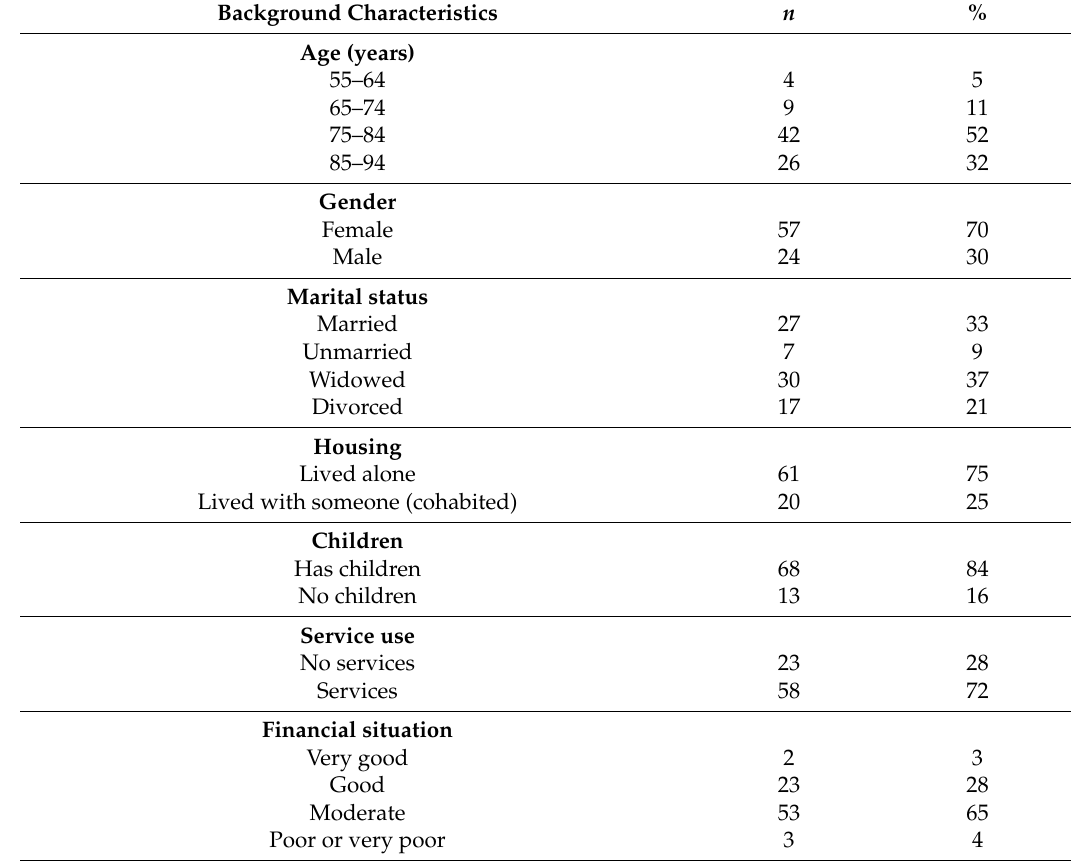
Table 4. Background characteristics of older people three months after relocation to senior housing ( n =